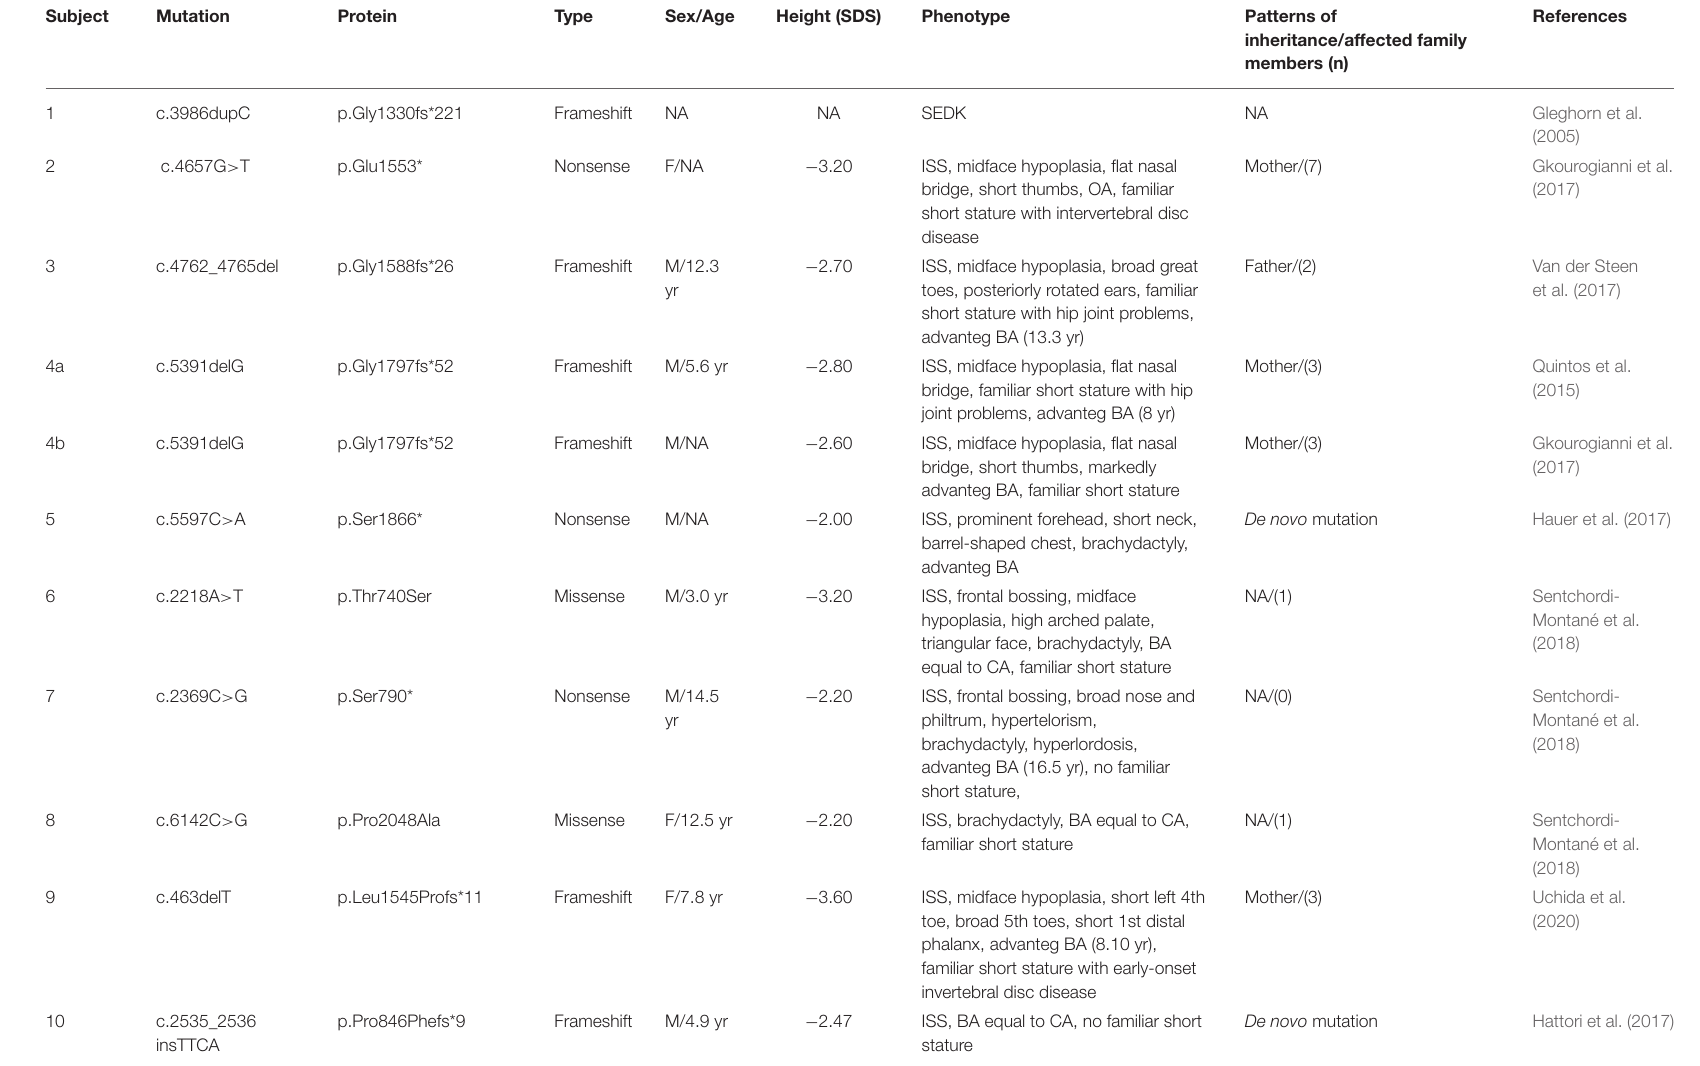
TABLE 3 | Clinical findings of patients with ACAN mutation in exon 12 in this study and the